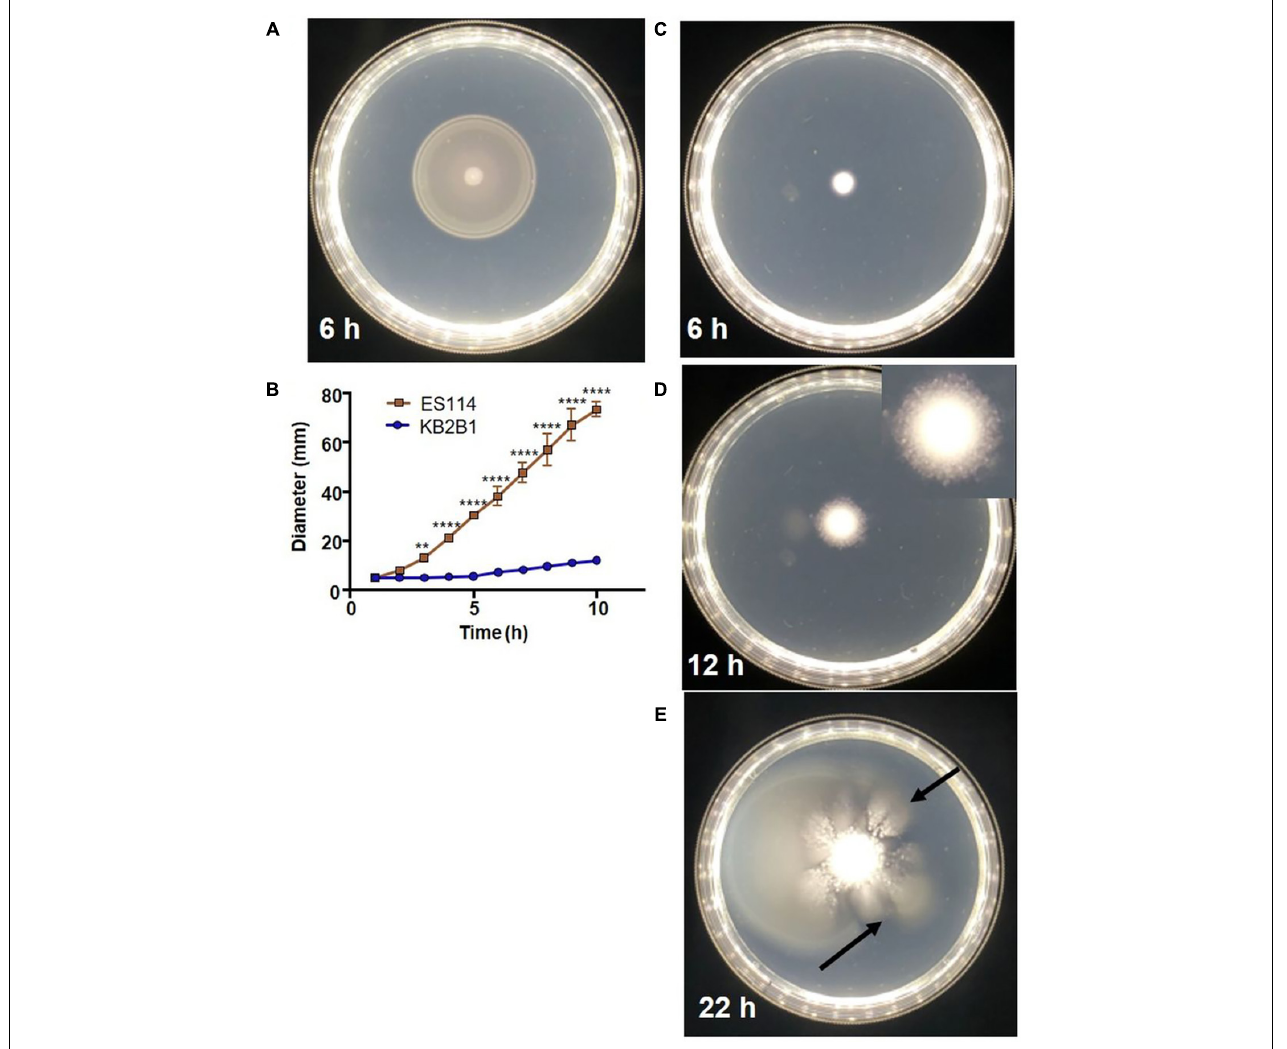
FIGURE 2 | Motility of wild-type Vibrio fischeri strains. Motility on TBS-Mg 2 + soft agar of strains ES114 (A) (6 h) and KB2B1 (6 h) (C) , 12 h (D) , and 22 h (E) . (B) The measurements of the size of the diameter of the migrating cells over time. (D) Inset image is cropped and magnified 1.5 × to show the appearance of the puncta. (E) Arrows point to suppressor mutants. Photos are representative of typical experiments. Statistics were done using a two-way ANOVA. ** p = 0.0074; **** p <